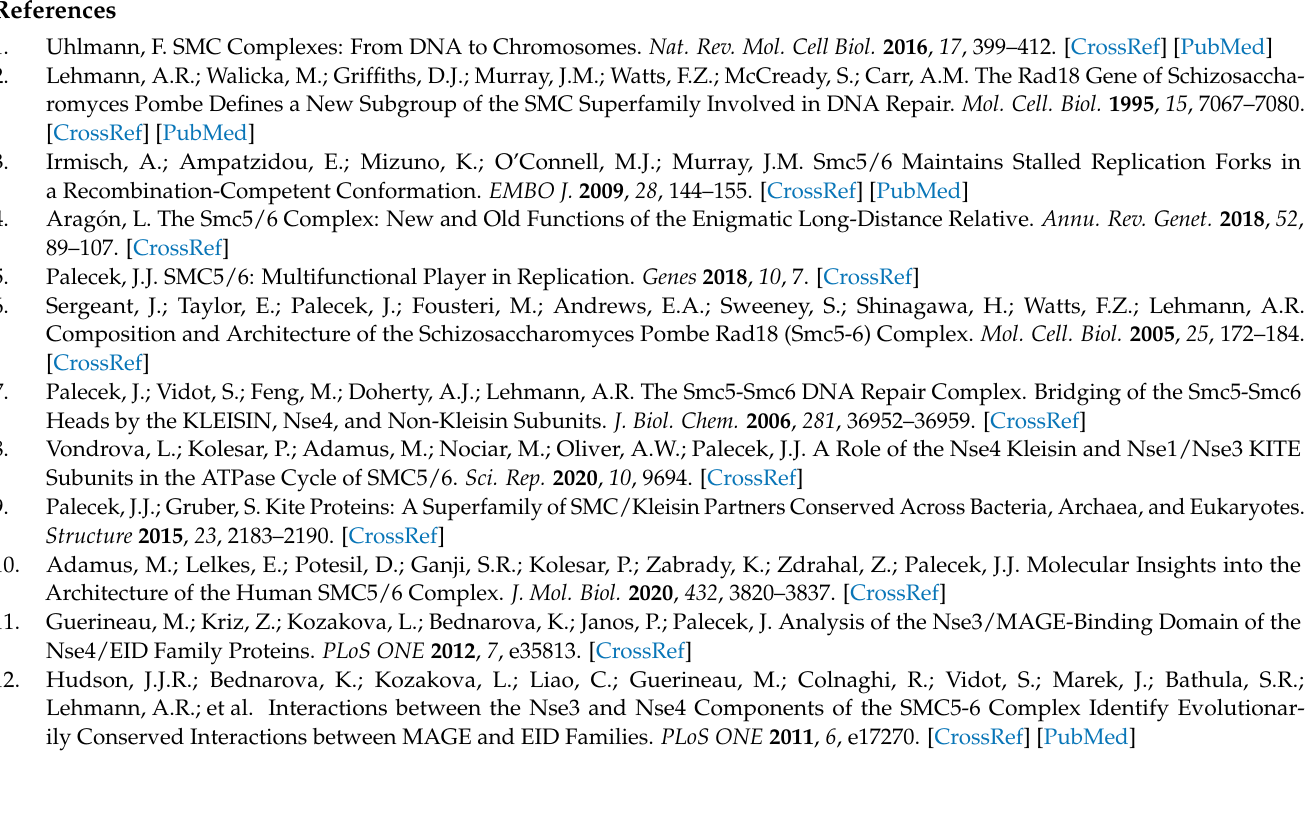
Figure S3: The HBH tag of the Nse1-HBH strain does not affect yeast cell growth or DNA-damage sensitivity, Figure S4: The C-terminal part of Nse1 interacts with ubiquitin in the yeast two-hybrid assay, Figure S5: The synthetic lethality and growth defect observed in the smc6-74 nse1-R188E and smc6-X nse1-R188E strains, respectively, are suppressed by the nse1-C216S mutation, Figure S6: Nse4- K181R does not suppress the sensitivity of nse6 ∆ , but suppresses smc6-X in the absence of Ubc7 , Figure S7: The C216S mutation does not inhibit Nse1 ubiquitin ligase